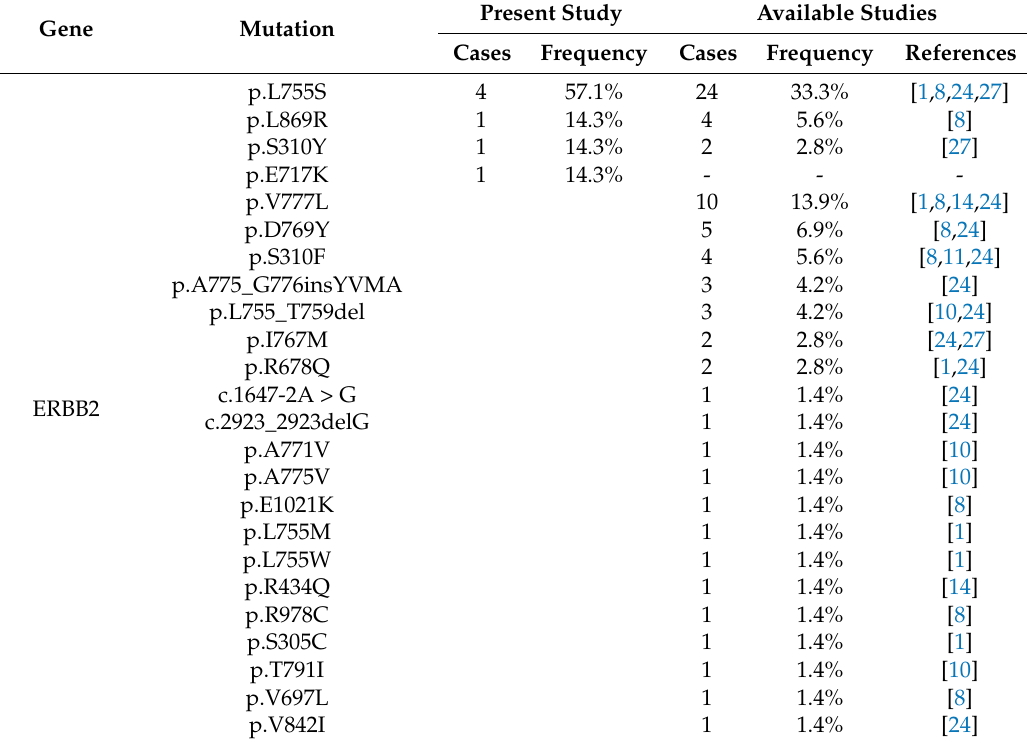
Table 3. ERBB2 mutations in invasive lobular